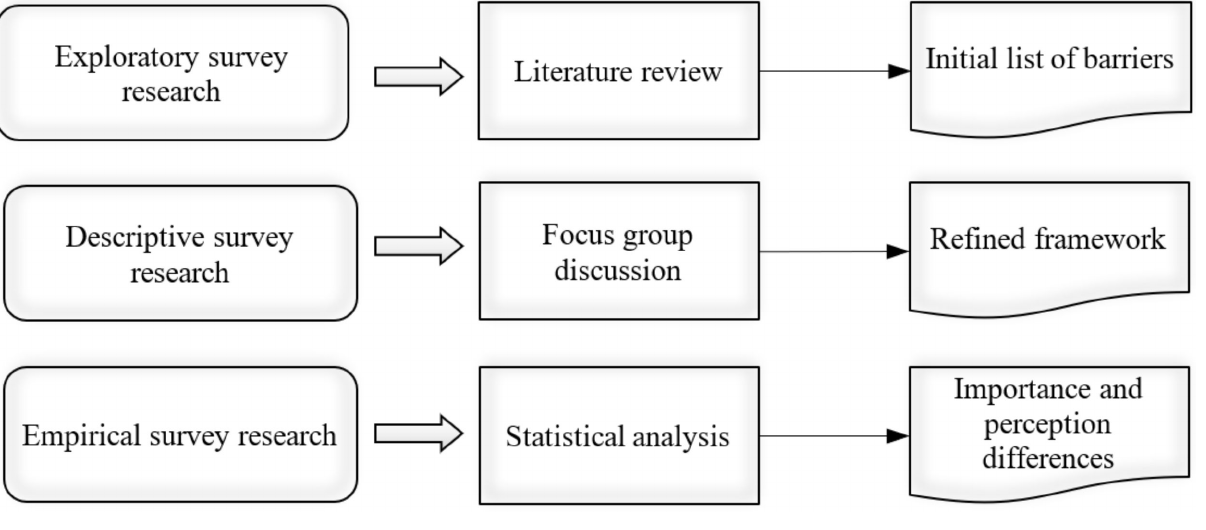
Figure 1. Research